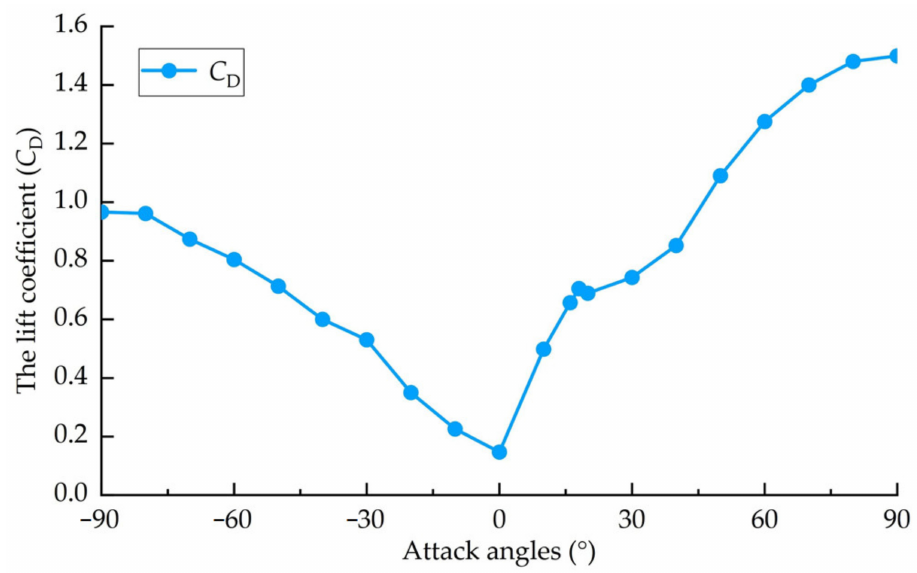
Figure 10. Drag coefficient at different attack angles.